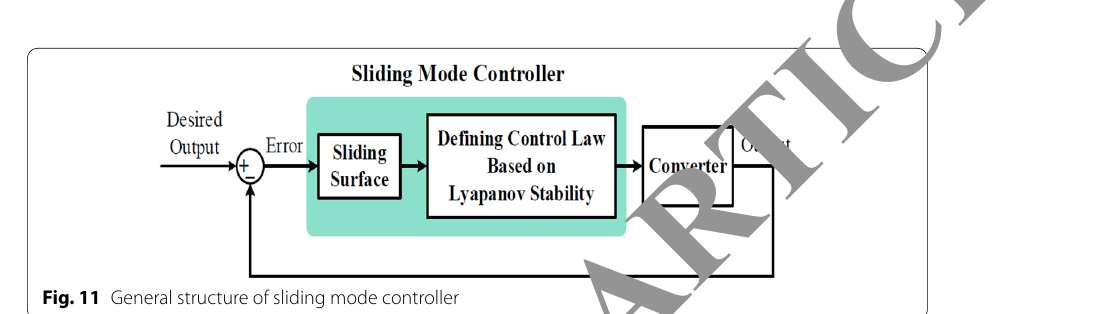
Fig. 11 General structure of sliding mode